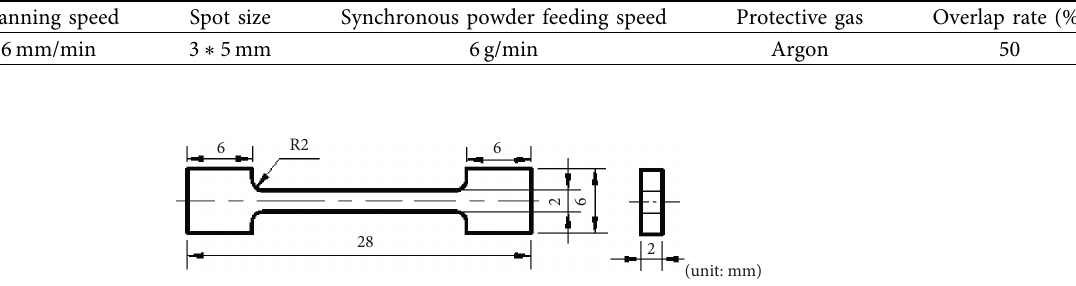
Figure 2: Schematic diagram of tensile test specimen.